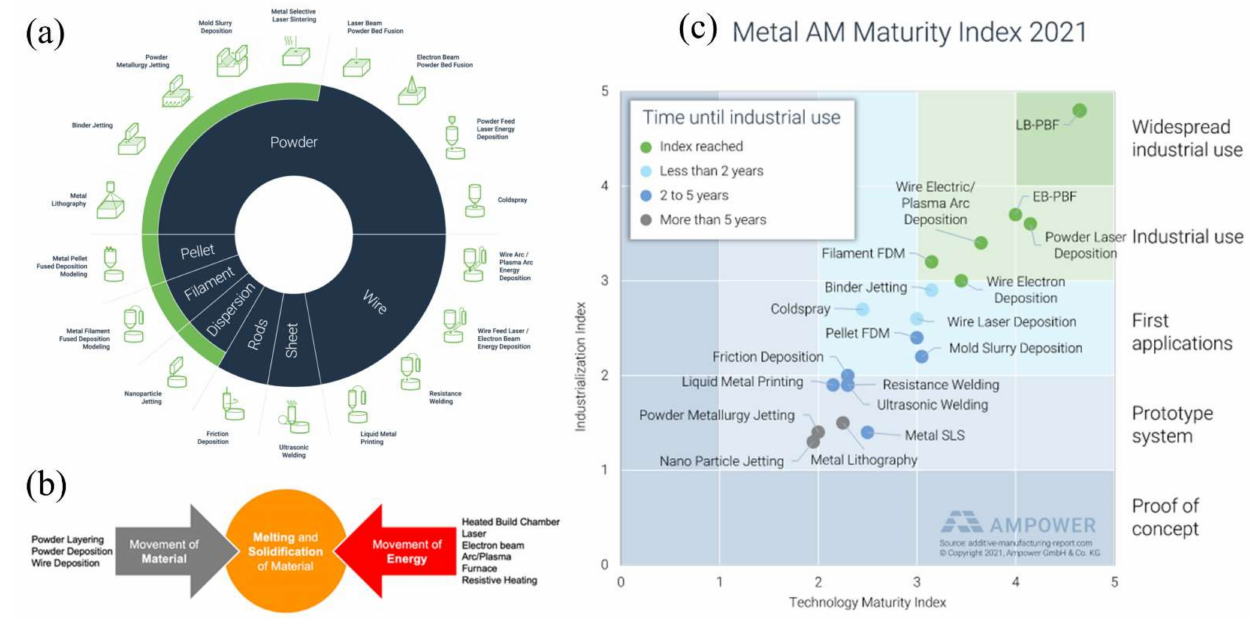
Figure 2. Metal Additive Manufacturing technology [11]. ( a ) Categorization based on the feedstock, ( b ) Physical concept, ( c ) AM Maturity